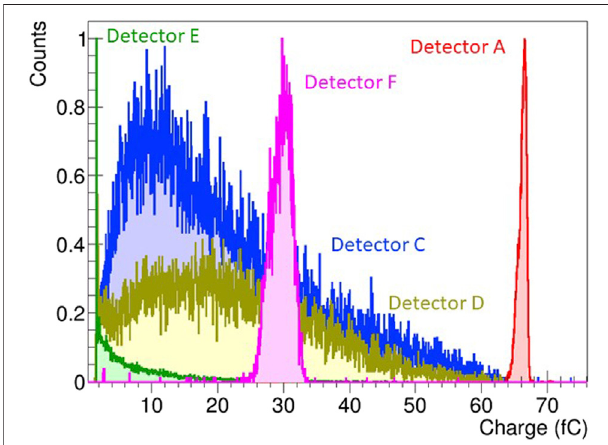
FIGURE 3 | Charge distribution measured using a 241 Am α source for diamond detectors A, C, D, E and F. The two α energies of the 241 Am (5,443 keV and 5,486 keV respectively) cannot be distinguished leading to a single ≈ 5.5 MeV α peakwitharesolutionof1.2%fordiamonddetectorA and a charge collection ef fi ciency of 100% against 30%, 32 and 44% respectively fordiamonds C, Dand F. Chargecollection ef fi ciency on detector E is too poor to be quanti fi ed. Diamond detectors were biased at 500 V and electron signal was collected [23].